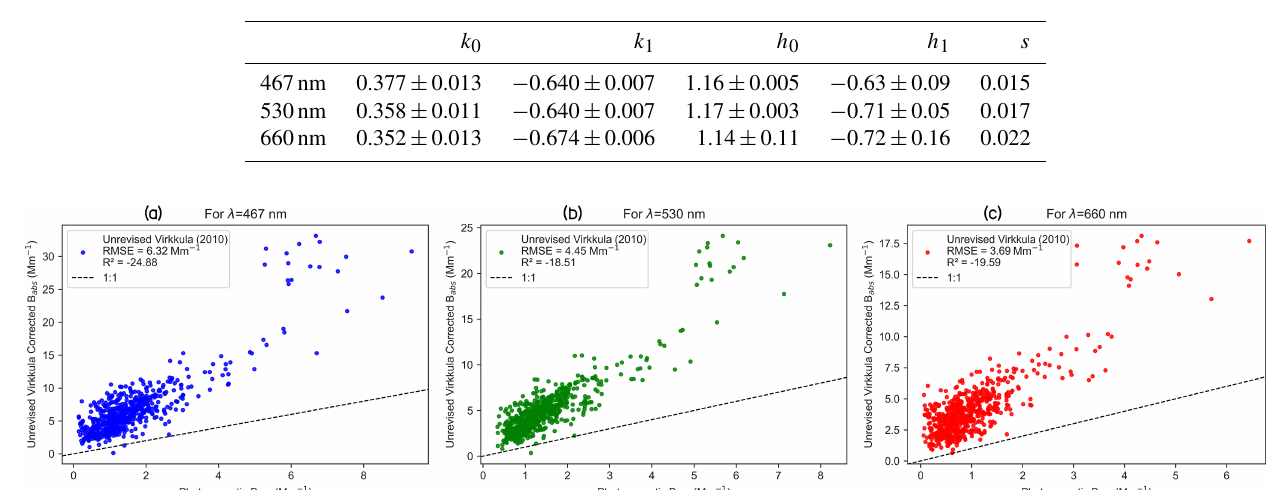
Table 1. Unrevised parameters as mentioned in Virkkula (2010) to be used in the Virkkula algorithm (i.e., Eq. 6).